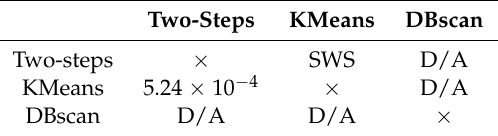
Table 18. p -values for instance